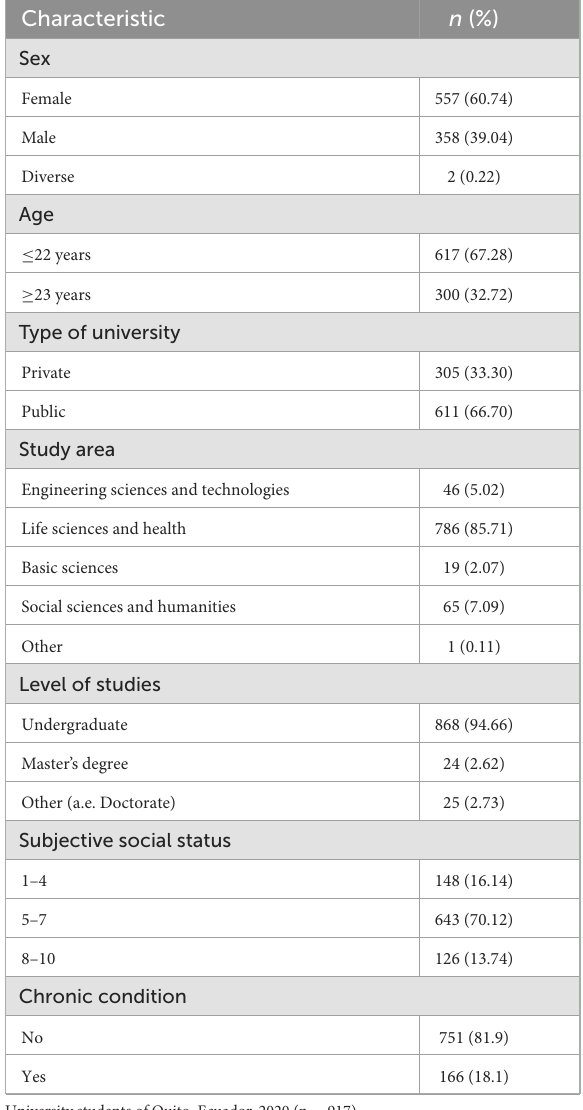
TABLE 1 Characteristics of the